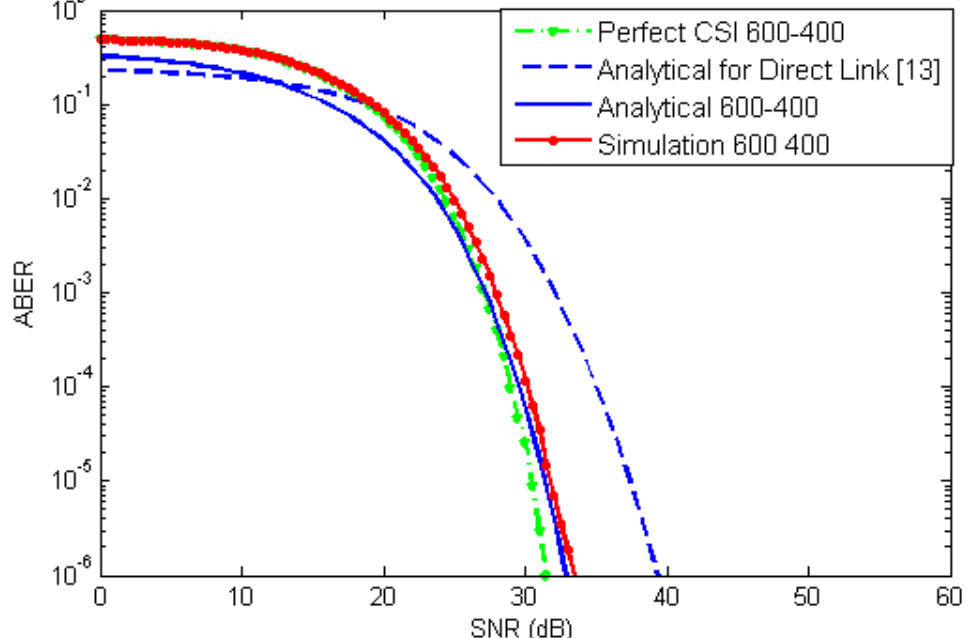
Figure 4. ABER performance for the direct link and a single relay after 600 m from the source, over weak turbulence.